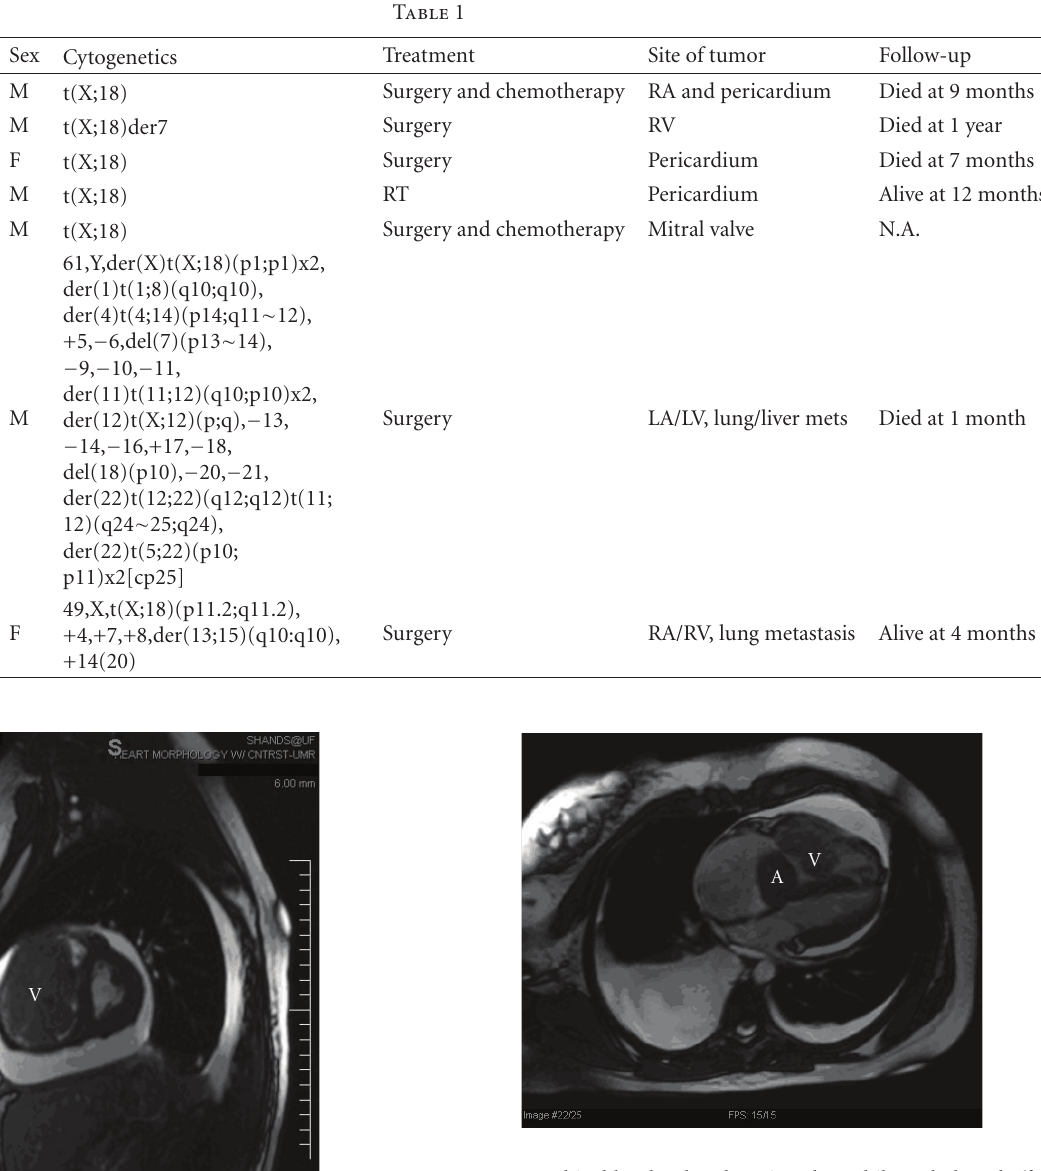
Figure 2: White blood 4 chamber view shows bilateral pleural e ff u- sions, pericardial e ff usion, right atrial and right ventricular enlarge- ment. There is a multilobed tumor mass in the right atrium (A) and right ventricle